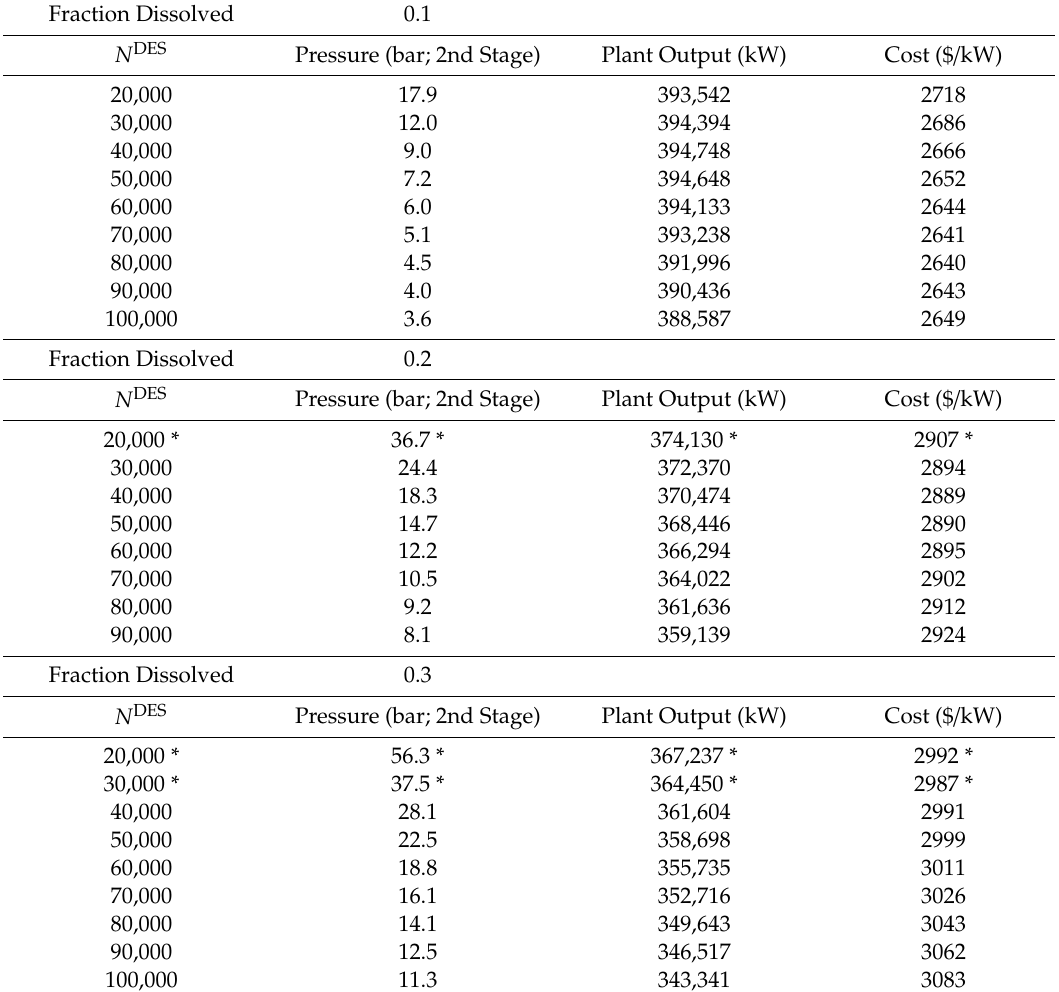
Table 4. Dual-Stage Model (Choline Chloride:Urea) system at 10%, 20%, and 30% CO 2